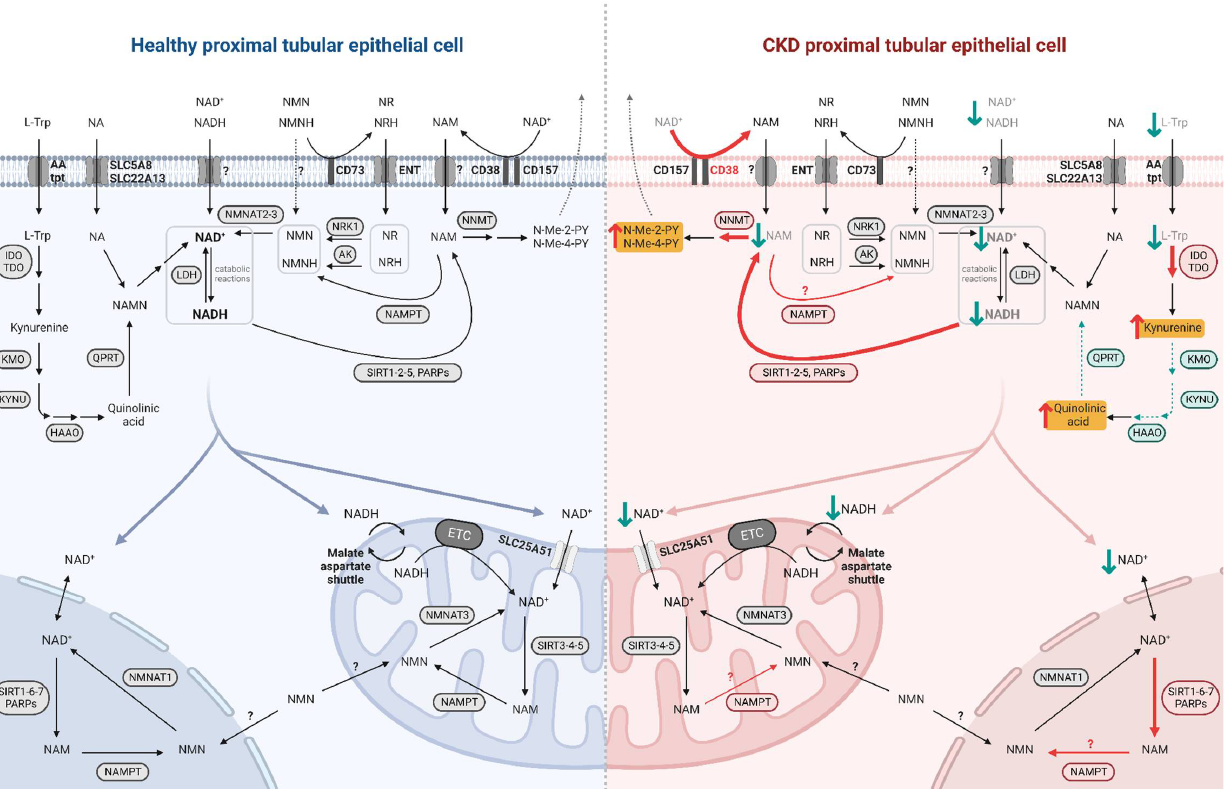
Figure 2. NAD + metabolism in healthy and diseased PTECs. NAD + precursors are taken up by specific transporters at the brush border of PTECs. NAD + biosynthesis occurs primarily in the cytosol while its consumption and salvage can occur in the cytosol, nucleus, and mitochondria, involving isoforms of enzymes specific to these compartments. NAD + moves freely between the nucleus and cytosol while it requires specific transport mechanisms to enter the mitochondria. In diseased PTEC (right side), NAD + biosynthesis is impaired and its consumption is increased, resulting in decreased NAD + levels and increased uremic toxin levels. Enhanced reactions and accumulated metabolites in CKD and premature renal aging are indicated by red arrows, with uremic toxins highlighted in yellow; impaired reactions and decreased metabolites are indicated by green arrows.